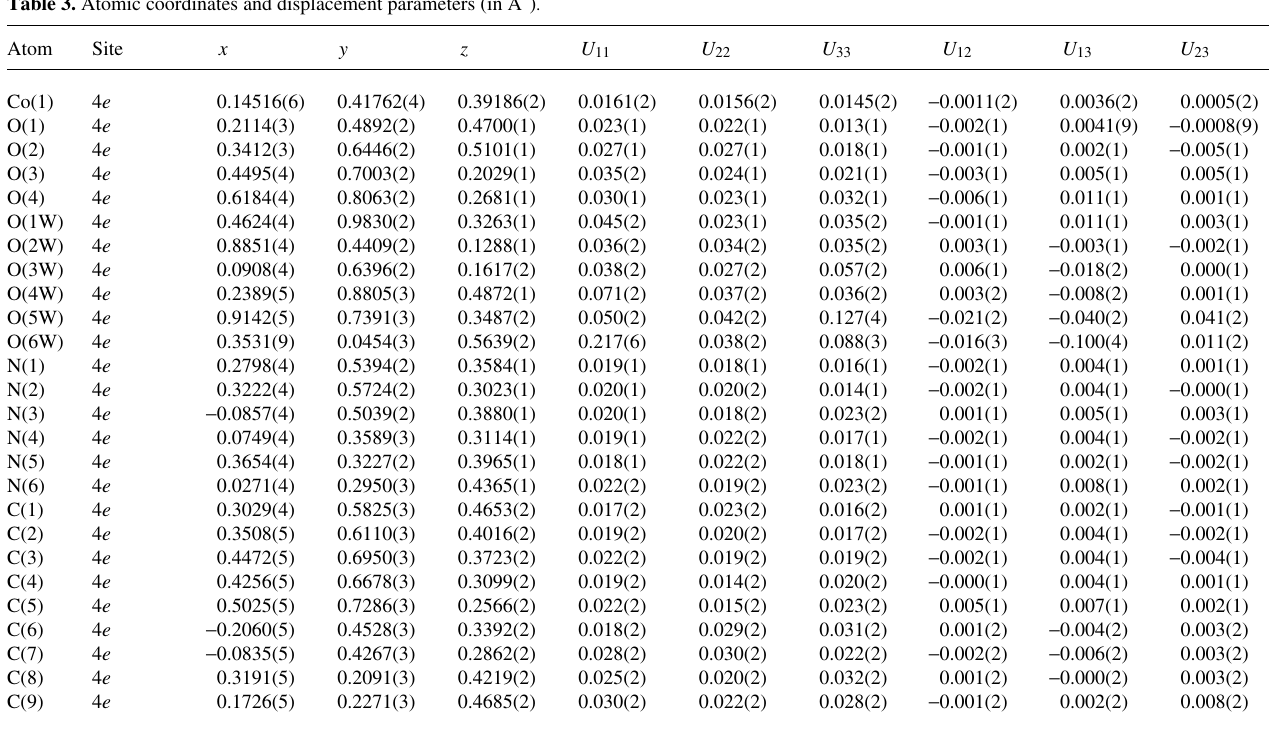
Table 3. Atomic coordinates and displacement parameters (in Å 2 )